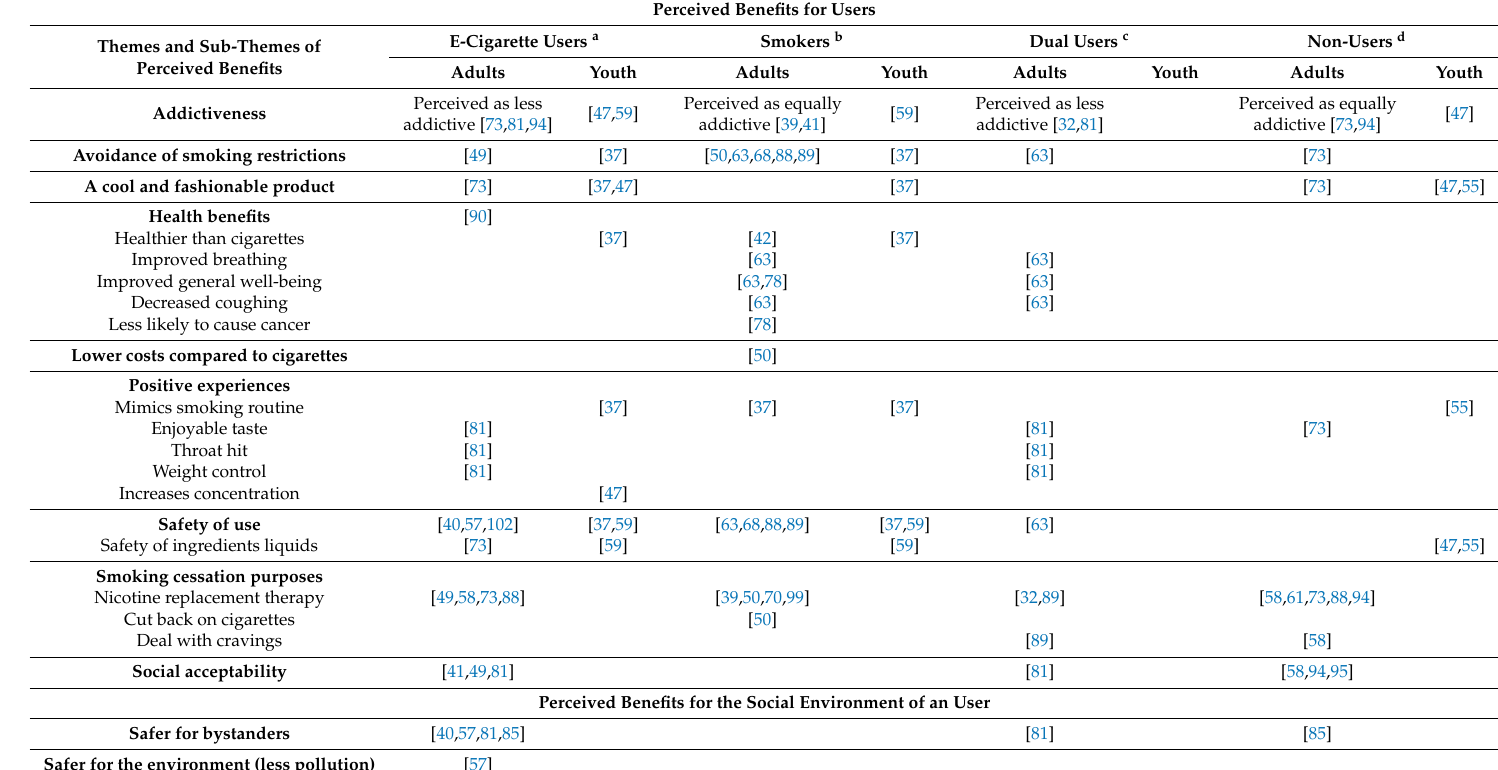
Table 2. Perceived benefits of e-cigarettes reported by individual studies, categorized by type of